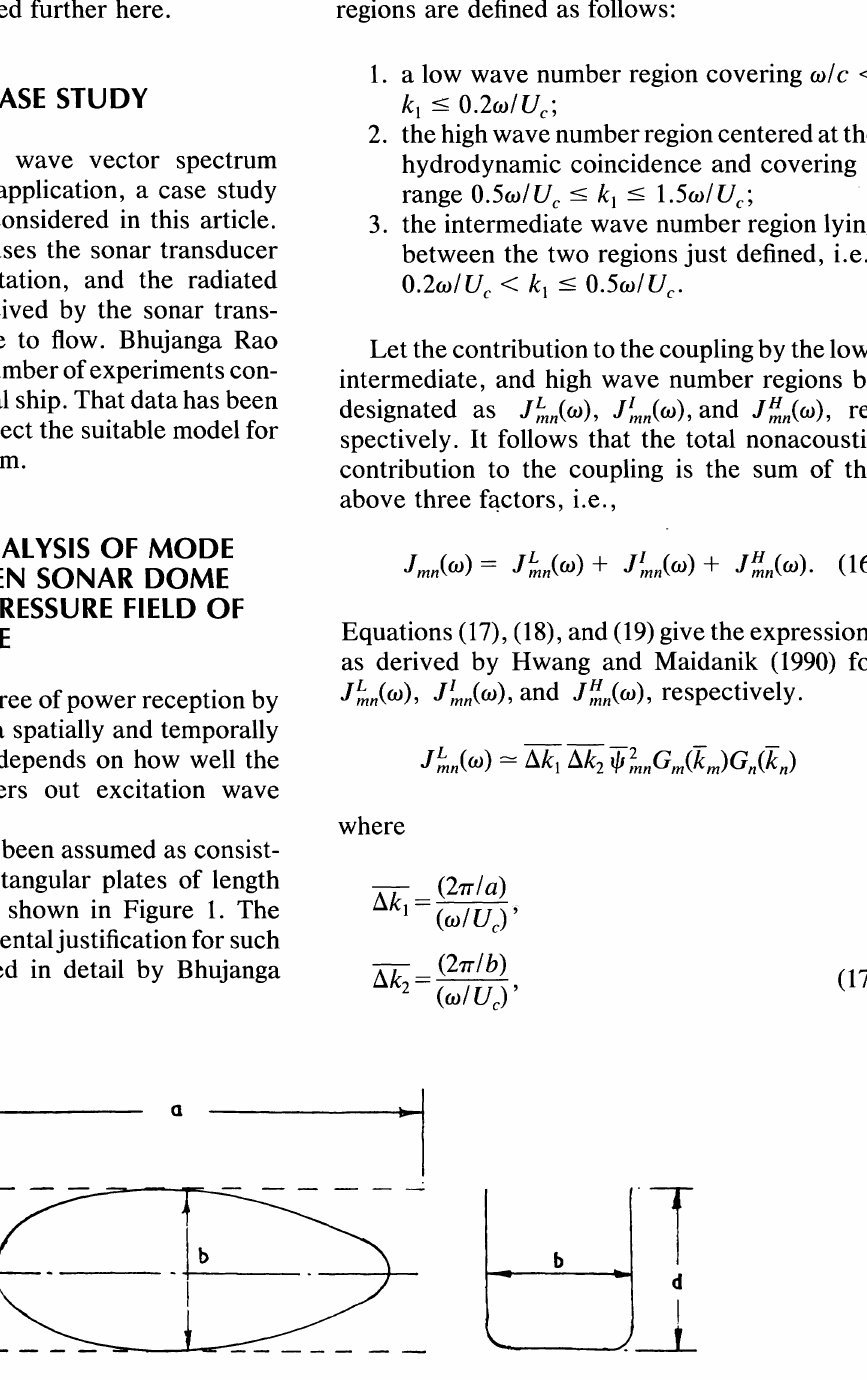
FIGURE 1 Idealization of curved dome wall as two equivalent fiat plates of length 'a' and breadth